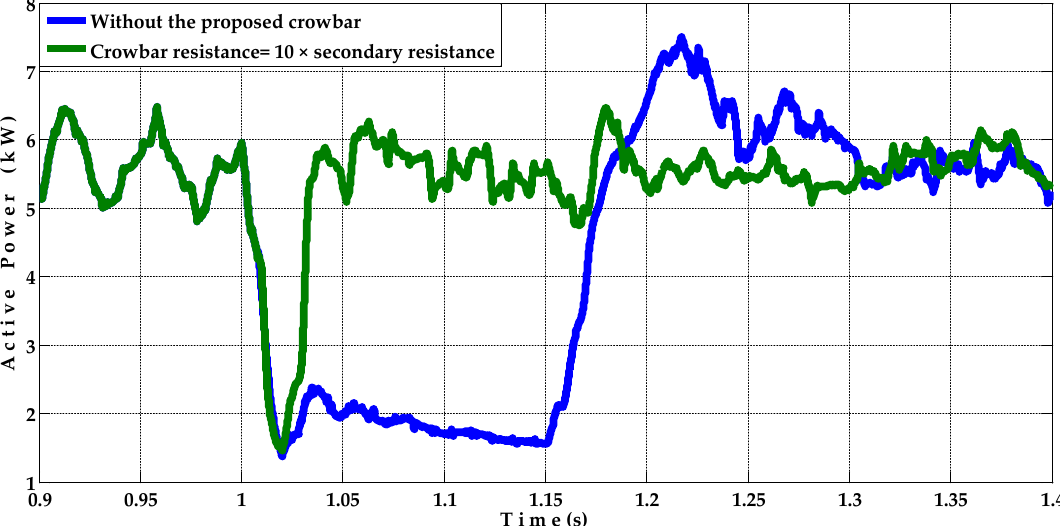
Figure 30. Active power of BDFRG with and without the proposed crowbar under double line to ground fault occurrence.